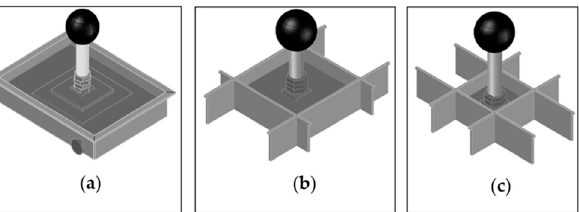
Figure 3. Instrumentation for measurement of force of friction on various surfaces: ( a ) bottomless box, ( b ) enclosure with dimensions of 105 × 105 mm, ( c ) enclosure with dimensions of 65 × 65 mm.